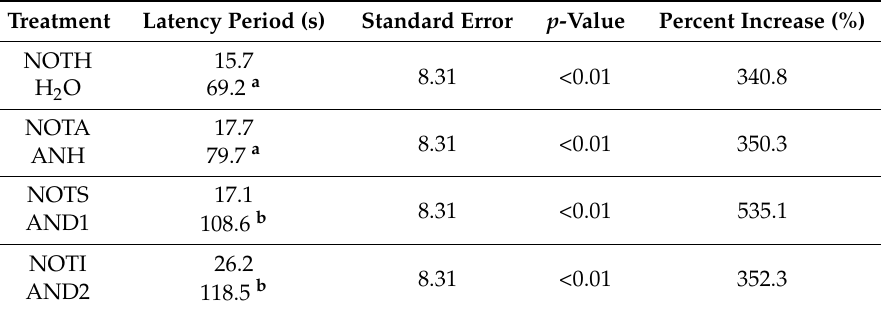
Table 5. Comparison of latency period between jumps for dogs receiving no correction (NOTH) vs. water-only spray (H 2 O), no correction (NOTA) vs. androstenone + water spray (ANH), androstenone 0.1 µ g/mL (AND1), or no correction (NOTI) vs. androstenone 1.0 µ g/mL (AND2) in response to each instance of jumping up. n = 10